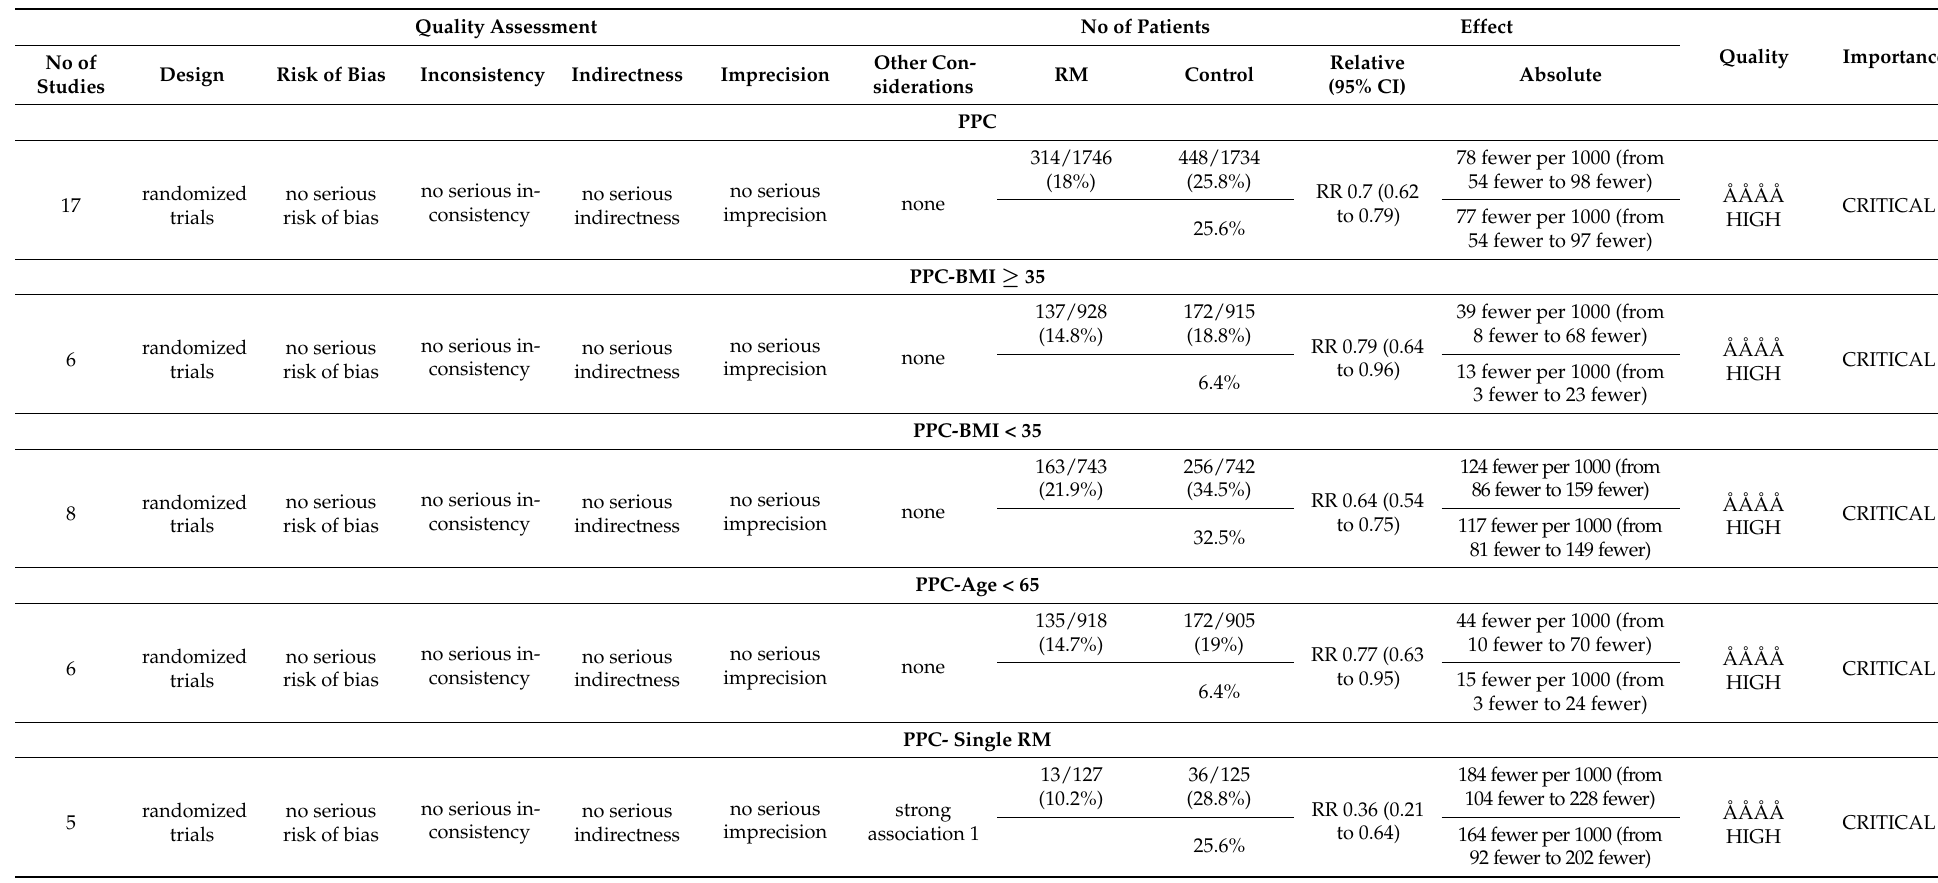
Table 3. Quality of evidence by